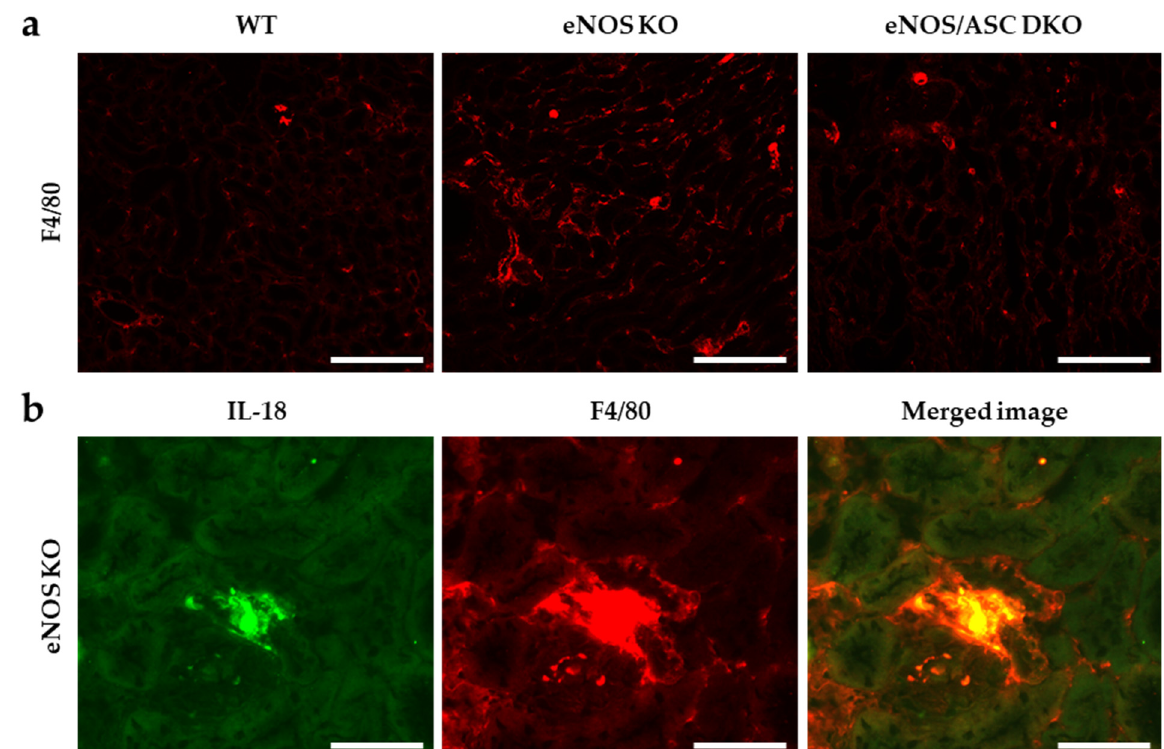
Figure 5. Macrophage infiltration and inflammasome activation in the tissue of aged mice: ( a ) immunofluorescence staining of F4/80 in kidney tissue. Bar = 250 μ m; ( b ) double-immunofluorescence analysis of IL-18, F4/80, and the merged image. Bar = 50 μ m. Green indicates FITC; red indicates Alexa Fluor 555.